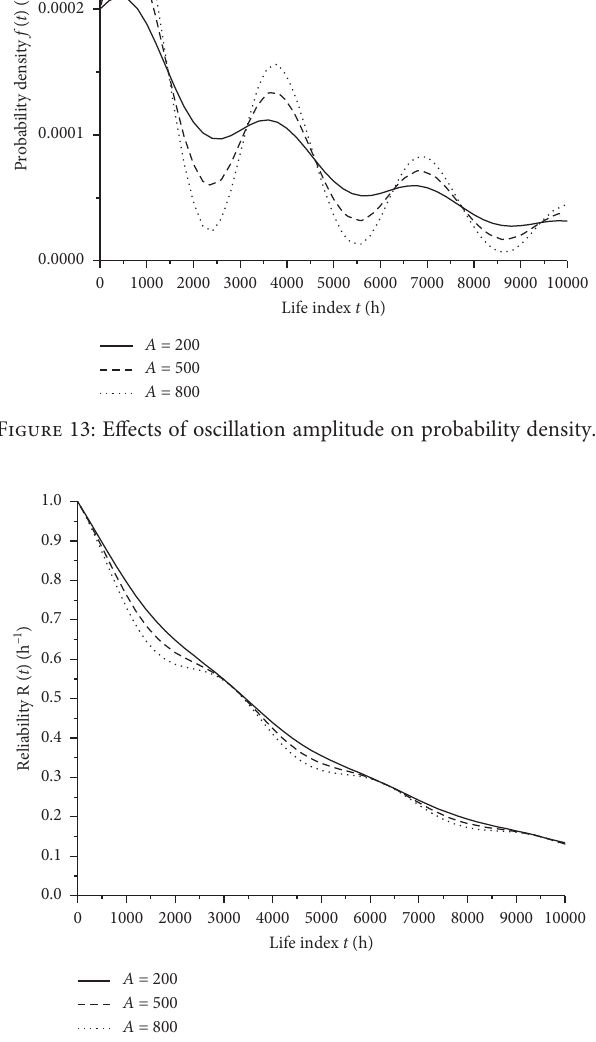
Figure 14: Effects of oscillation amplitude on reliability.